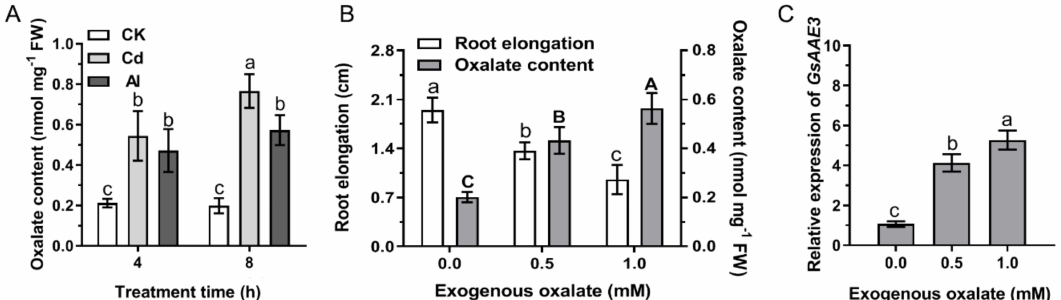
Figure 1. The e ff ect of Cd and Al stresses and exogenous oxalate on wild soybean (BW69) root tips. ( A ) Cd and Al stresses induced oxalate accumulation. The seedlings were exposed to nutrient solution containing 0 or 30 µ M CdCl 2 or AlCl 3 for 4 or 8 h. ( B ) The e ff ect of exogenous oxalate on wild soybean root elongation and oxalate content. The seedlings were exposed to 0, 0.5, 1.0 mM sodium oxalate for 24 h. Root elongation was measured with a ruler before and after treatment ( n = 16). After treatment, the root tips (0–2 cm) were ground into fine powder with liquid nitrogen and then extracted with distilled water for oxalate content analysis ( n = 3). The lowercase letters mean statistical significance of comparisons of root elongation data, and the uppercase letters mean statistical significance of comparisons of oxalate content data. ( C ) Correlation between oxalate content and GsAAE3 expression ( n = 3). The expression of GsAAE3 was determined by qRT-PCR. All data are presented as means ± SD. Di ff erent letters indicate statistically significant di ff erence, using one-way ANOVA and Duncan’s test ( p ≤